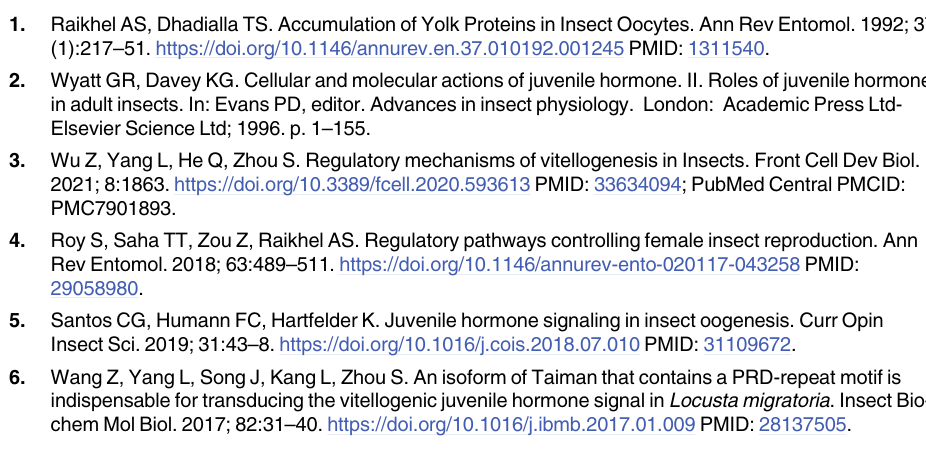
different letters indicate significant difference at P < 0.05. n = 3. (TIF) S3 Fig. Quantitative analysis of p-Par3 and p-aPKC band intensity from Western blots representatively shown in Fig 5C. Means labeled with different letters indicate significant dif- ference at P < 0.05. n = 3. S4 Fig. Quantitative analysis of p-Par3 and p-aPKC band intensity from Western blots representatively shown in Fig 6C. Means labeled with different letters indicate significant dif- ference at P < 0.05. n = 3. S5 Fig. Validation of p-Par3 antibody specificity. Upper panel: Western blots using protein extracts isolated from follicular epithelia of 8-day-old adult females subjected to Par3 RNAi (A), aPKC RNAi (B) and λ PP treatment (C). Lower panel: quantitative analysis of band inten- sity from Western blots representatively shown in the upper panel. � , P < 0.05; �� , P < 0.01; compared to the dsGFP control. n = 3. S1 Table. Primers used for PCR cloning, RNAi and